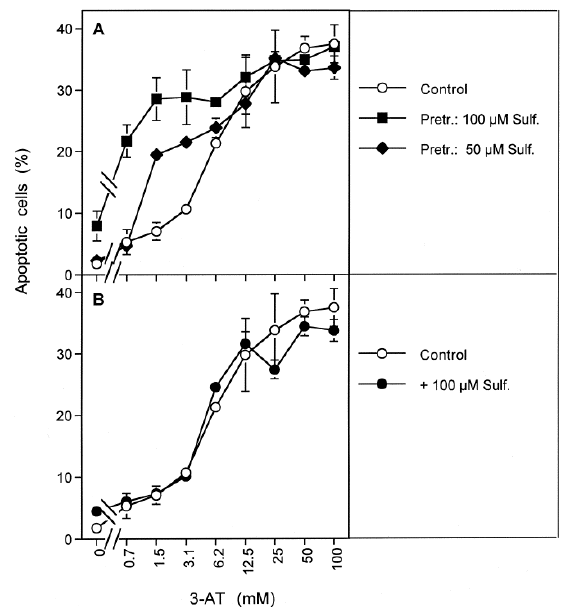
Figure 10. Pretreatment of tumor cells with the xCT inhibitor sulfasalazine enhances apoptosis induction after application of low concentrations of 3-AT. MKN-45 cells (200,000 cells/mL) were pretreated for 14 h in the absence of sulfasalazin (control) or presence of 50 µ M or 100 µ M sulfasalazine. After pretreatment, cells were washed and reseeded at a density of 12,500 cells/well in 96 well tissue culture clusters. ( A ): Control cells and cells pretreated with 50 µ M or 100 µ M sulfasalazine received the indicated concentrations of 3-AT. ( B ): Control cells remained without further addition or received 100 µ M sulfasalazine immediately before the application of 3-AT. Assays as described under ( A , B ) were incubated for 5 h and the percentages of apoptotic cells were determined. The results show that pretreatment with sulfasalazine caused an enhancement of apoptosis induction in the low concentration range of 3-AT, but not at higher concentrations of 3-AT. Addition of sulfasalazine together with 3-AT had no enhancing effect. Statistical analysis. The enhancement of 3-AT-mediated apoptosis induction through pretreatment with sulfasalazine was highly significant ( p < 0.001), whereas there was not significant effect of sulfasalazine added together with 3-AT.